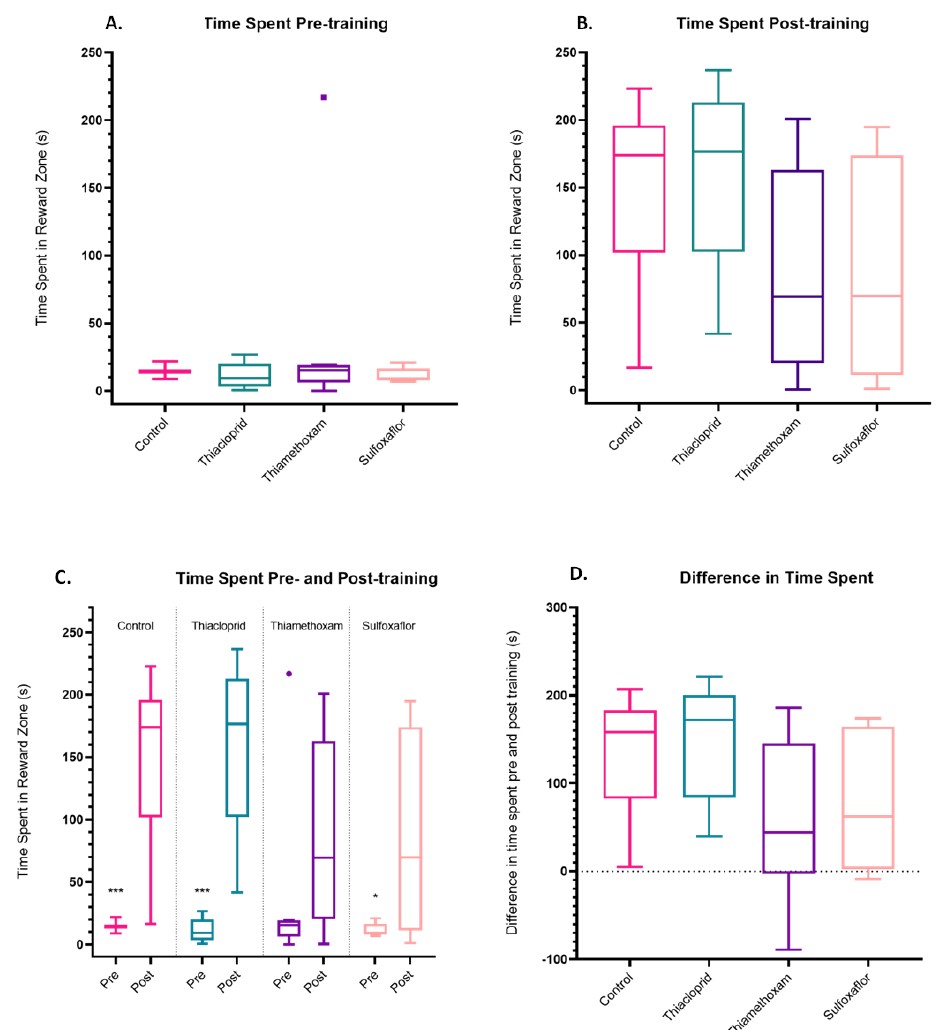
Figure 4. Time spent in the reward zone by bees in the lower concentration trials. ( A ) Time spent in the reward zone pre-training. p (cid:61) 0.99 for all comparisons (Kruskal-Wallis test with multiple comparisons). ( B ) Time spent in the reward zone post-training. p values range from 0.21 to 0.99 (one-way ANOVA with Tukey correction for multiple comparisons). ( C ) Time spent in the reward zone pre- versus post-training. Control (paired t -test, p = 0.0004 ***, t = 5.901, df = 8), thiacloprid (paired t -test, p = 0.0002 ***, t = 6.594, df = 8), sulfoxaflor (Wilcoxon matched-pairs signed rank test, p = 0.0195 *). Bees in the thiamethoxam treatment did not significantly increase the time they spent in the reward zone post training (versus pre-training) (Wilcoxon matched pairs signed rank test, p = 0.1289), but this is likely because one individual outlier ( (cid:4) ) spent a large amount of time in the reward zone pre-training (216.8 s), as when this individual is removed the comparison becomes significant for all other bees in the thiamethoxam treatment ( p = 0.0391 *). ( D ) Difference in time spent (post-training − pre-training value). A positive value indicates a bee improved, spending more time in the reward zone post-training whereas a negative value indicates the bee got worse at the task, decreasing the time spent in the reward zone post-training. Control n = 9, sulfoxaflor n = 9, thiacloprid n = 9; thiamethoxam n =